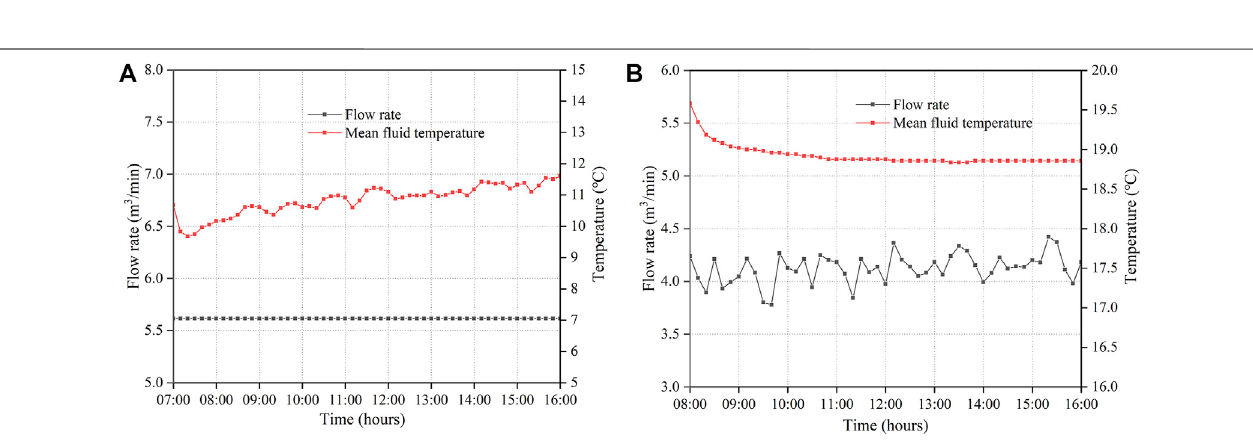
Frontiers in Earth Science |